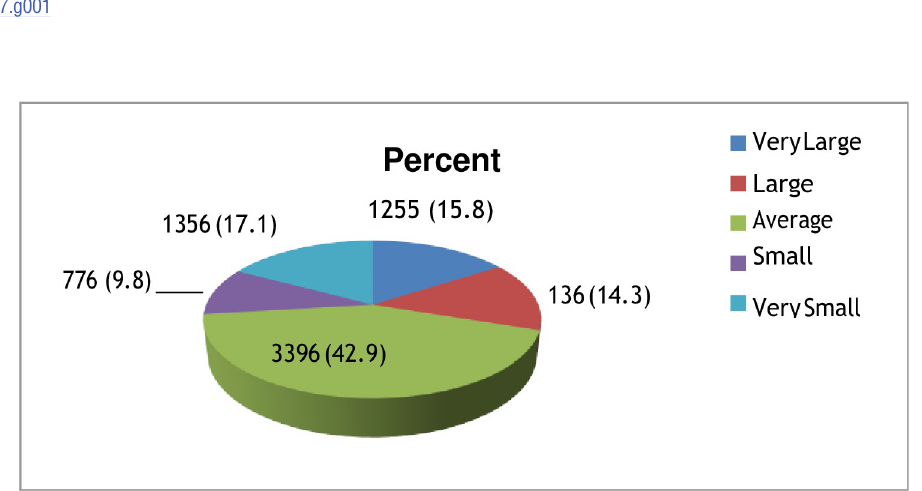
Fig 2. The prevalence of proximate low birth weight in Ethiopia as reported from mothers.